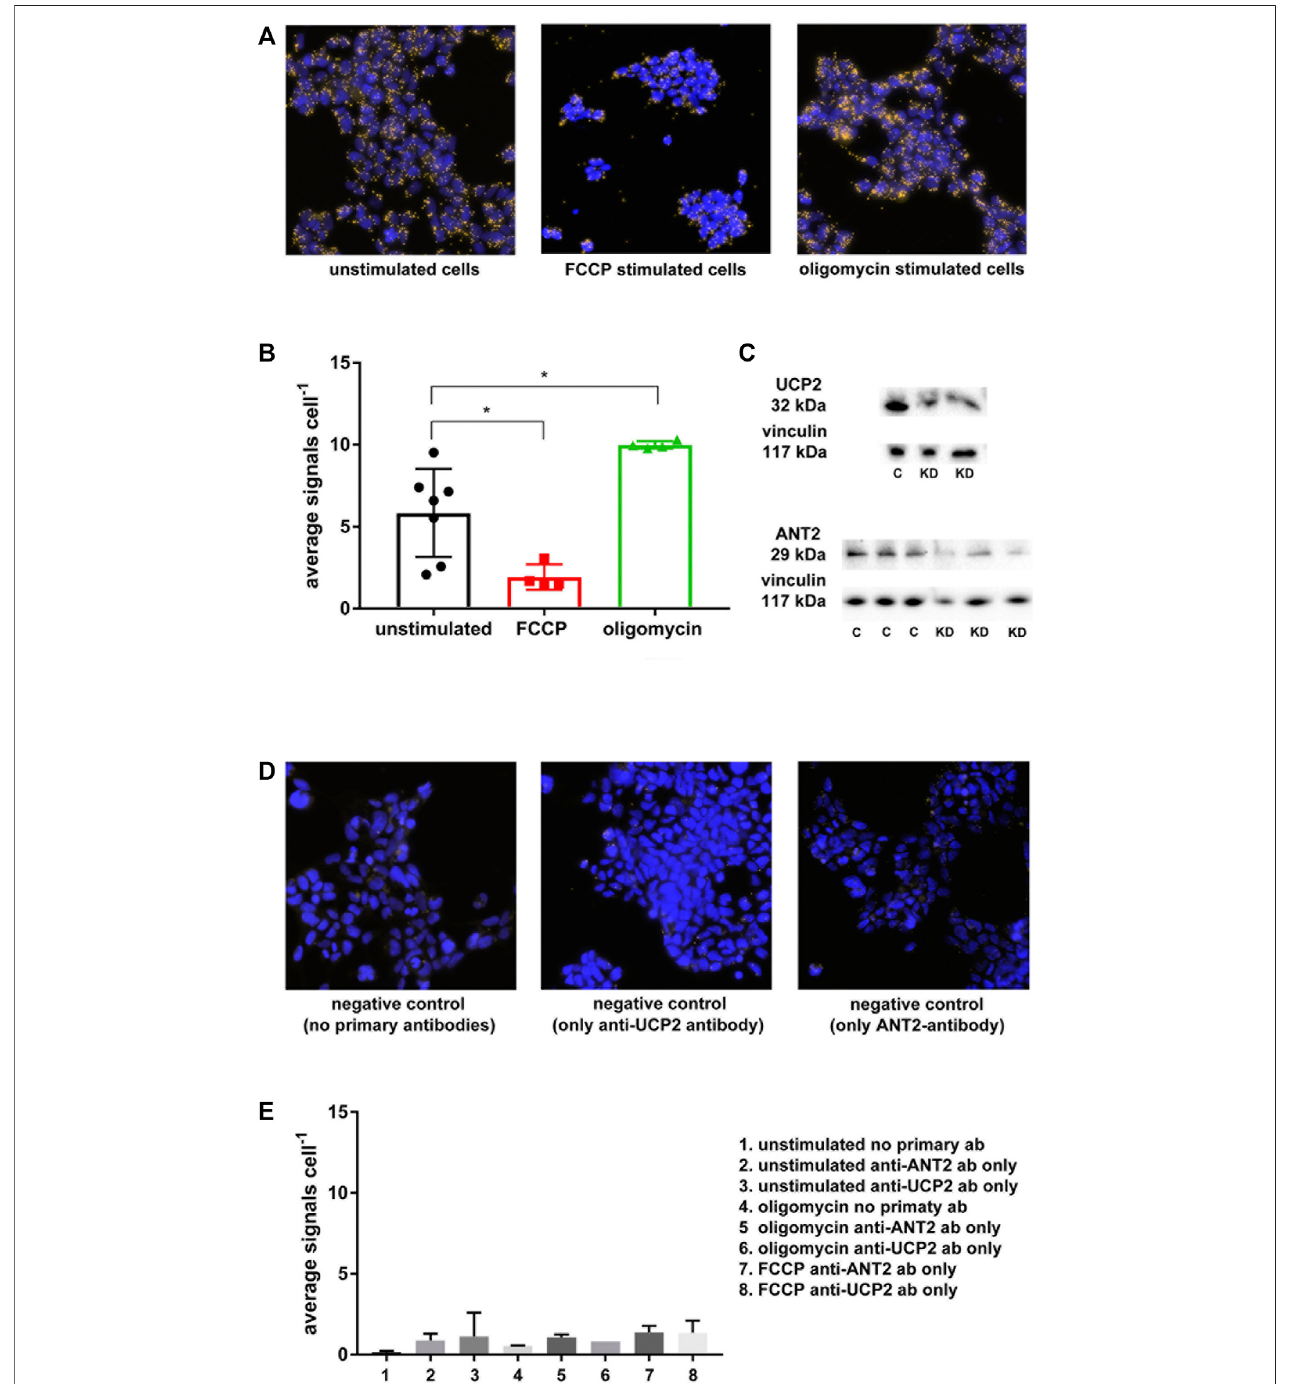
FIGURE 3 | In situ PLA was performed on HEK293 cells using anti-ANT2 and anti-UCP2 antibodies. Yellow dots represent a within approximately 40 nm co- localization of UCP2 and ANT2. (A) Unstimulated cells represent cells at basal condition, whereas FCCP stimulated cells represent arti fi cially induced mitochondrial respiration and lowering of membrane potential via mitochondrial uncoupling. Oligomycin stimulated cells represent the lowest possible respiration together with the highestpossiblemembranepotentialviaATP-synthaseinhibitionwitholigomycin. (B) ,GraphdisplayingtheextentofANT2-UCP2interactiondependentoncellular respiration explained in (A) . (C) Native PAGE was performed to con fi rm binding of the anti-UCP2 and anti-ANT2 to the native proteins. (D) Negative controls using only secondary antibodies or secondary antibodies in presence of either primary anti-ANT2 or anti-UCP2 antibodies. (E) Graph representing negative controls displayed as the average number of PLA signals per